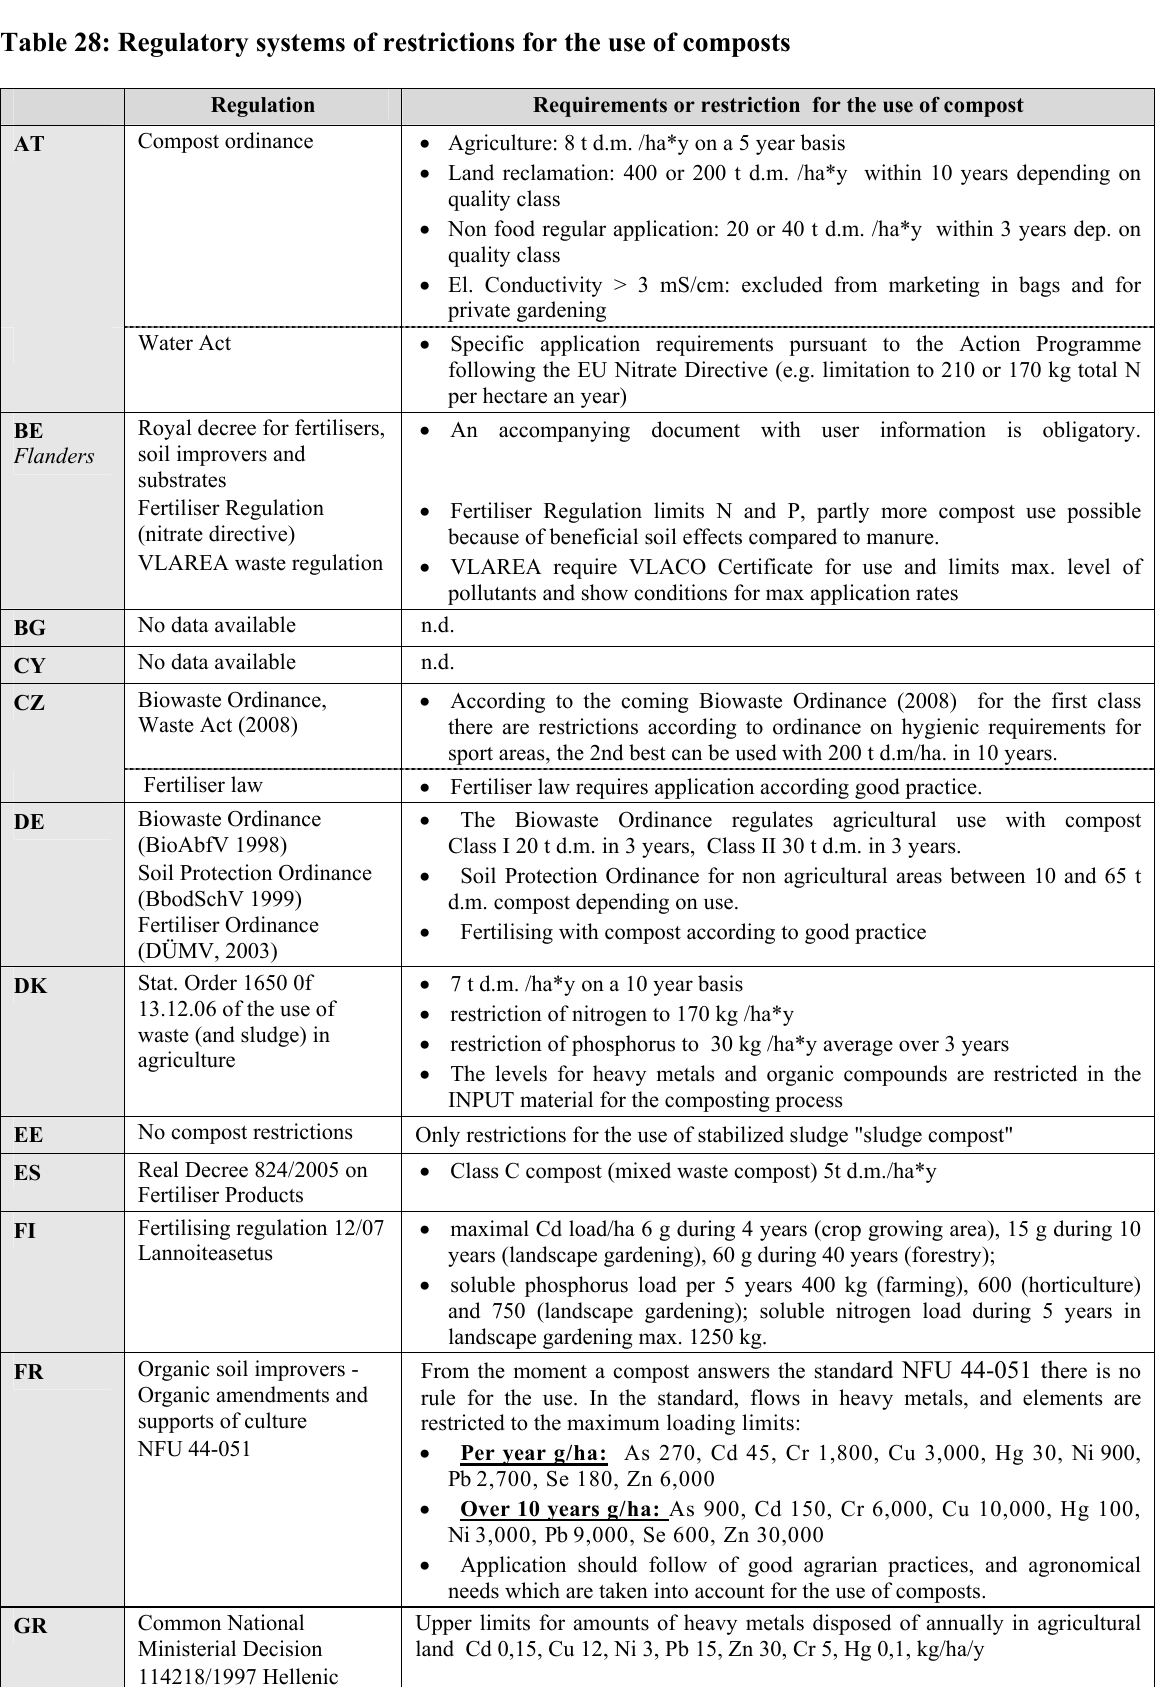
Table 28: Regulatory systems of restrictions for the use of composts Regulation Requirements or restriction for the use of compost